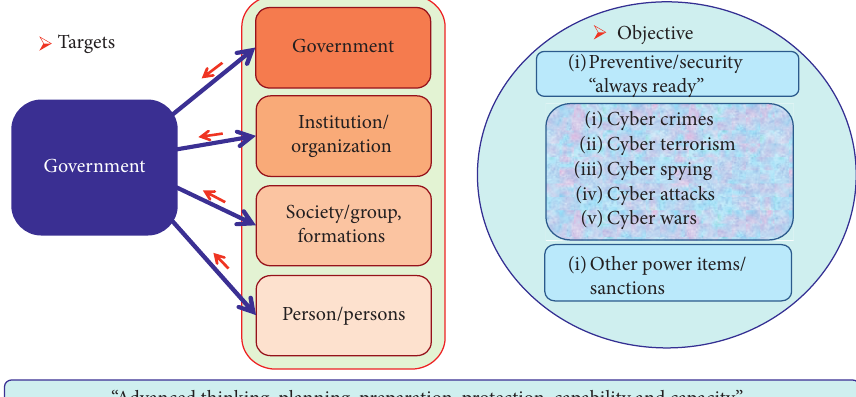
Figure 3: Deterrence targets and objective.